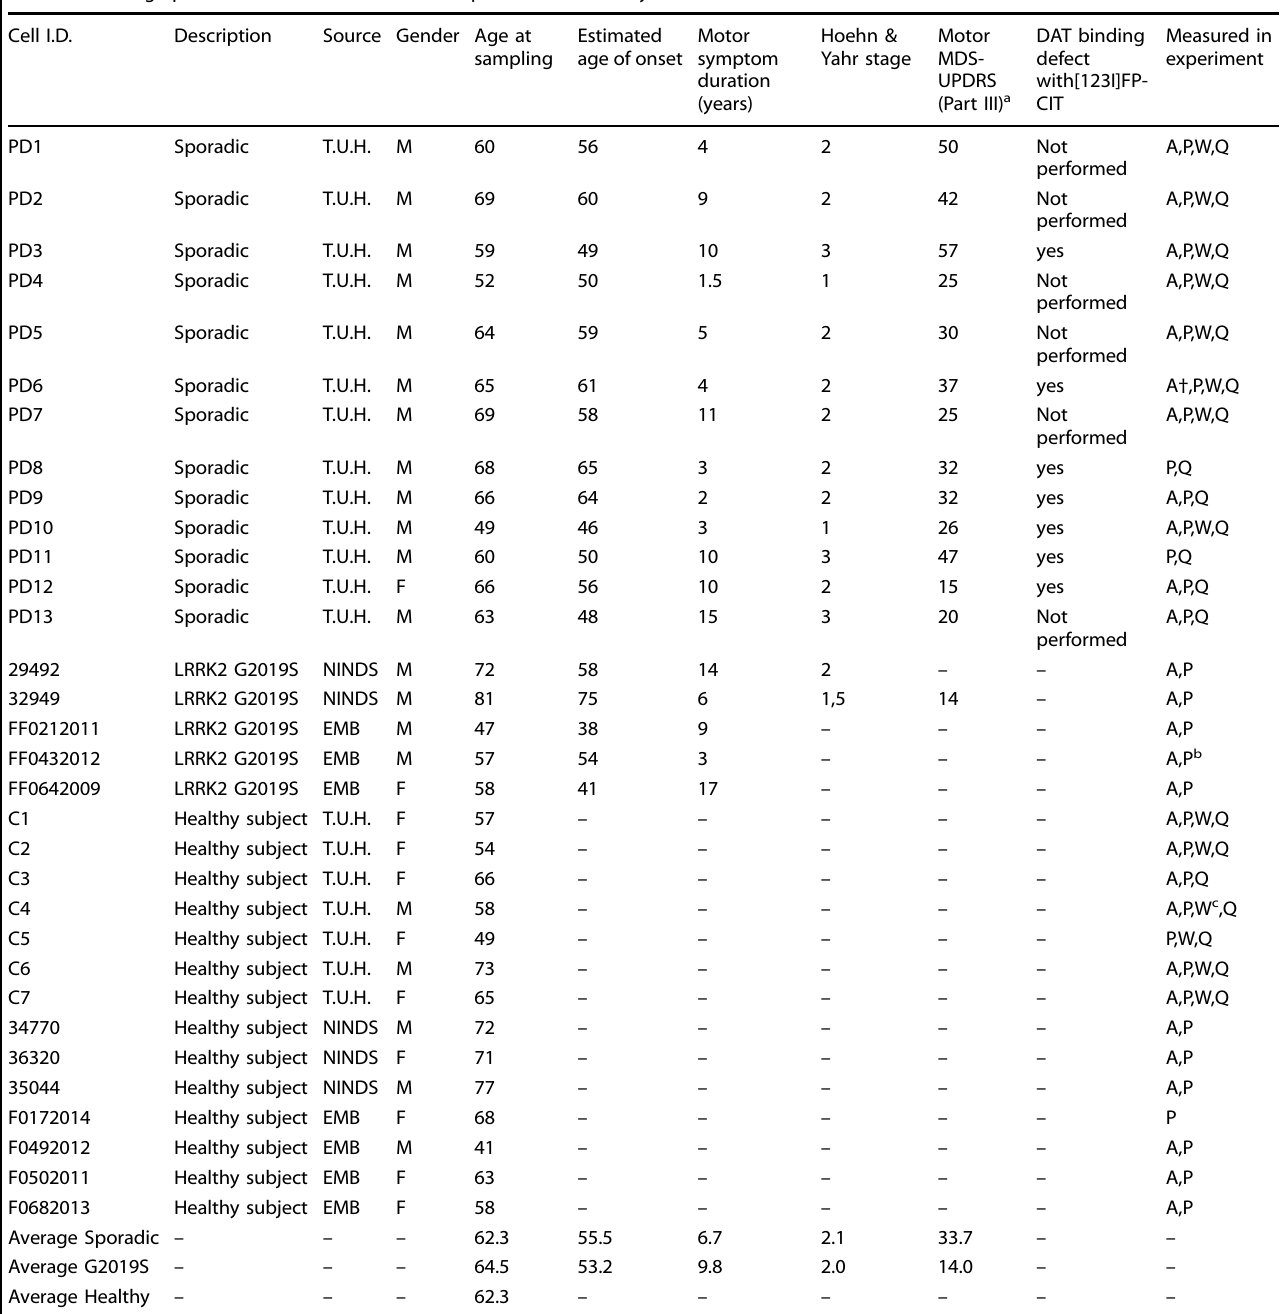
Table 1. Demographic and clinical characteristics of patients and healthy controls. Cell